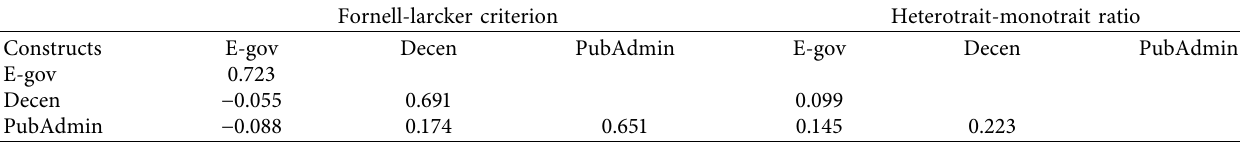
Figure 2: Model testing results. Table 4: Discriminant validity.